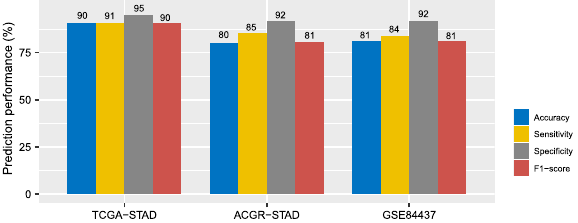
Fig. 10 Prediction performance of the pathway-based GC classi- fi cation method. TCGA-STAD as the training set and ACRG-STAD and GSE84437 as test sets to predict the three subtypes by XGBoost 83 . The prediction accuracies and weighted sensitivity, speci fi city, and F1-scores in TCGA-STAD (tenfold cross-validation), ACRG-STAD, and GSE84437 are